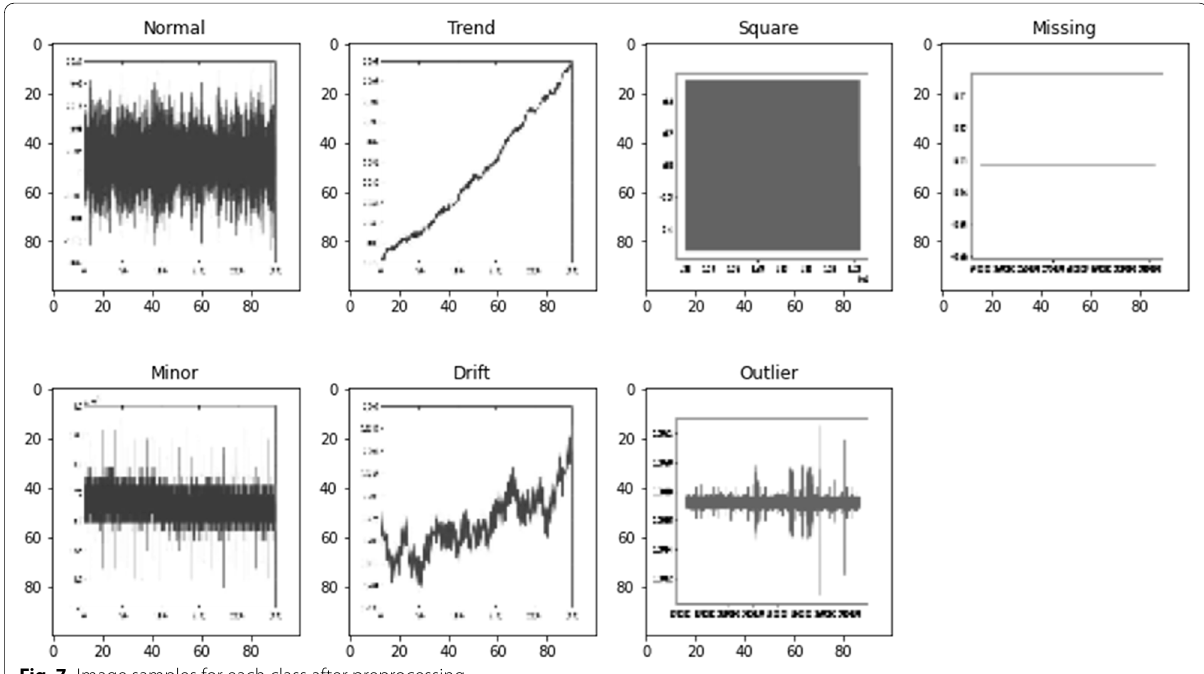
Fig. 7 Image samples for each class after preprocessing